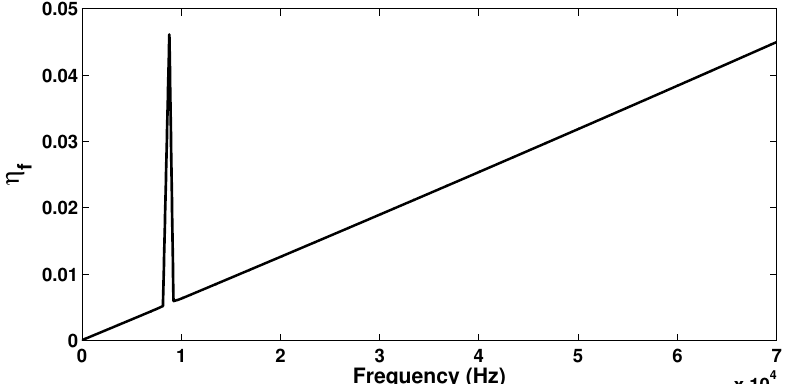
Figure 7. The frequency-dependent total loss factor for the flexural wave propagating within the laminate with a shunted piezoelectric patch and C